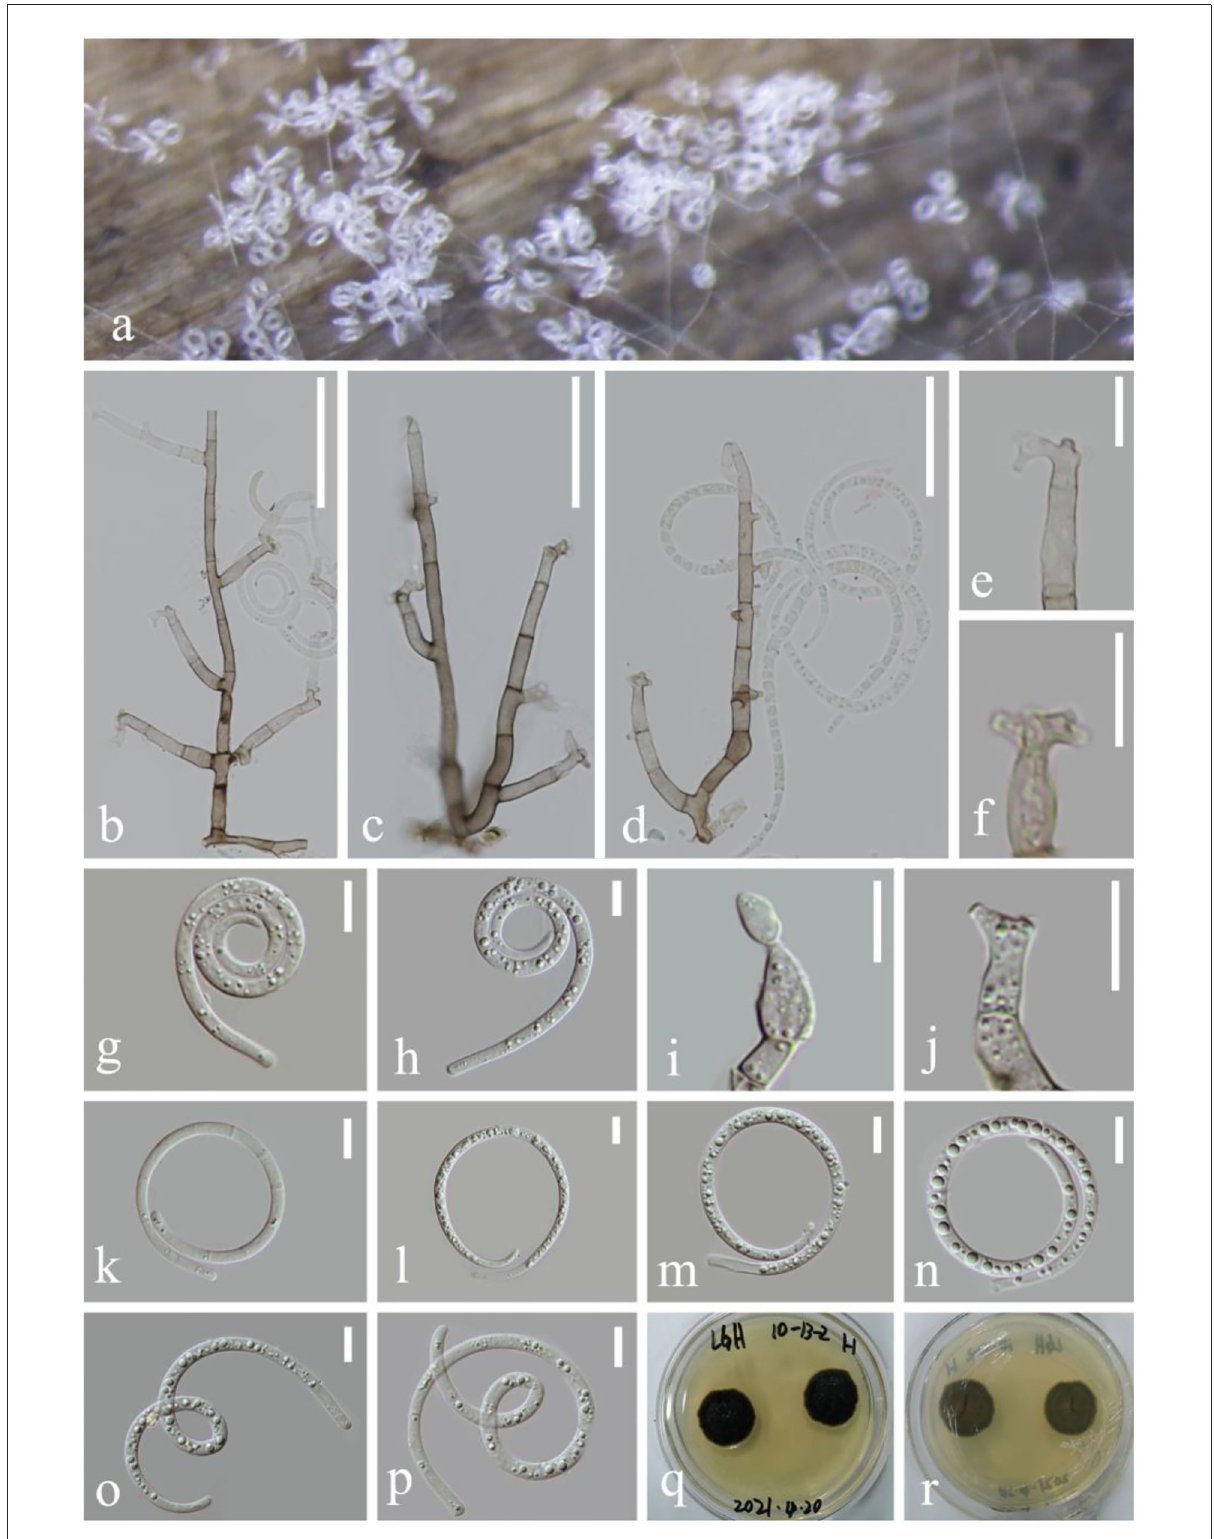
FIGURE6 Parahelicomyces hyalosporus (KUN-HKAS 124603). (a) Colony on decaying wood. (b–d) Conidiophores with attached conidia and lateral minute polyblastic denticles. (e,f,i,j) Conidiogenous cells. (g,h,k–p) Conidia. (p,q) Colony on PDA observed from above and below. Scale bars: (b) 50 µ m, (c,d) 40 µ m, and (e–p) 10 µ